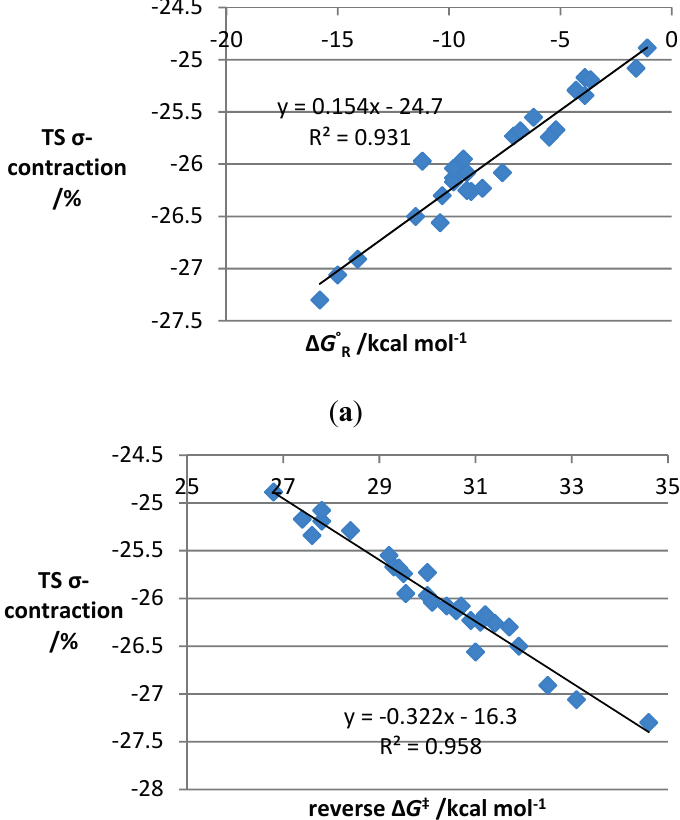
Figure 2. Plots of TS σ -contraction vs. key energetic parameters in our experimentally studied data. ( a ) TS σ -contraction vs. Gibbs free energies of the reaction for IMDAF reactions 1 – 26 ; ( b ) TS σ -contraction vs. reverse Gibbs free energy barrier for IMDAF reactions 1 – 26 ; ( c ) TS σ -contraction vs. Gibbs free energy of activation for IMDAF reactions 1 – 26